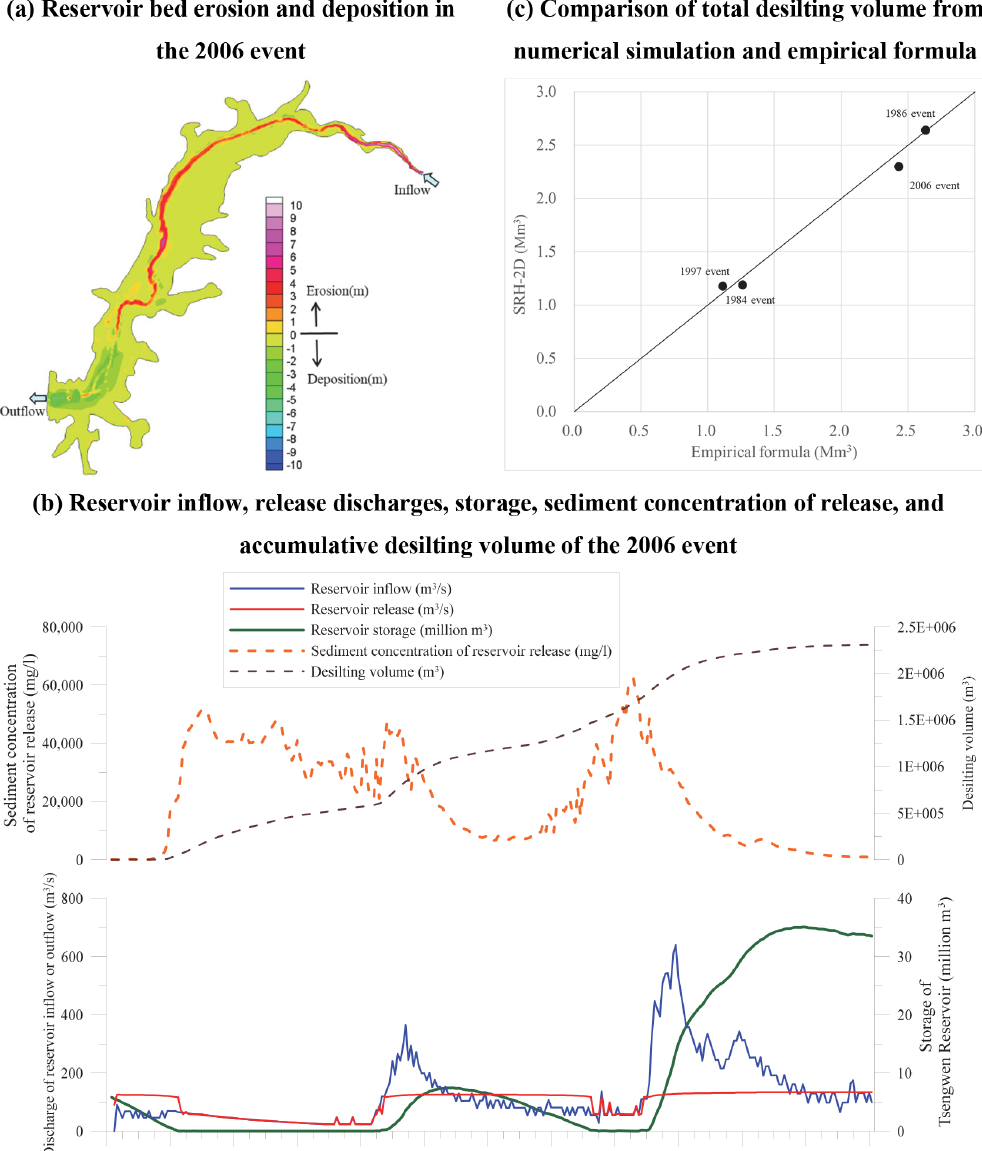
Figure A2. Simulation results of the